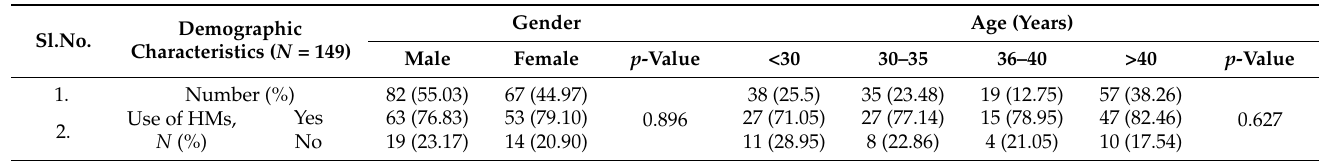
Table 1. Demographic characteristics and use of HMs based on age and gender of the respondents, using chi-square ( χ 2 ) tests ( N = 149).